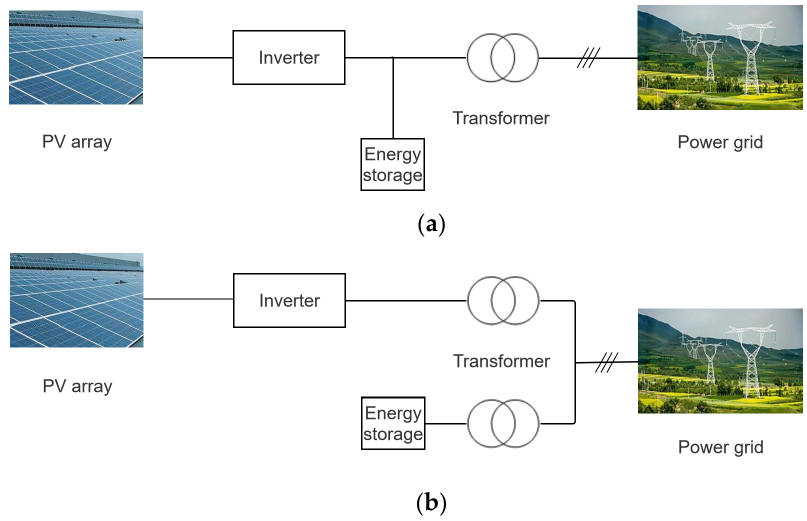
Figure 4. Schematic of PV-energy storage system: ( a ) PV energy storage system configured on the AC low-voltage side; ( b ) PV energy storage system configured on the AC high voltage side.